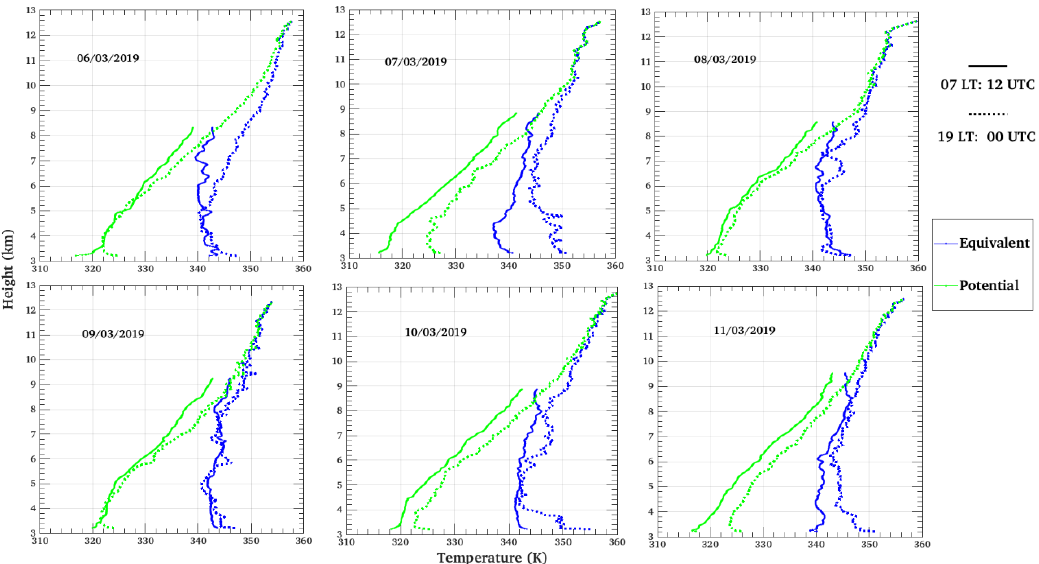
Figure 12. Vertical profile of equivalent potential and potential temperature during the rainy periods (6th March to 11th March 2019). The solid and dashed lines are at 12:00 and 00:00 UTC respectively.